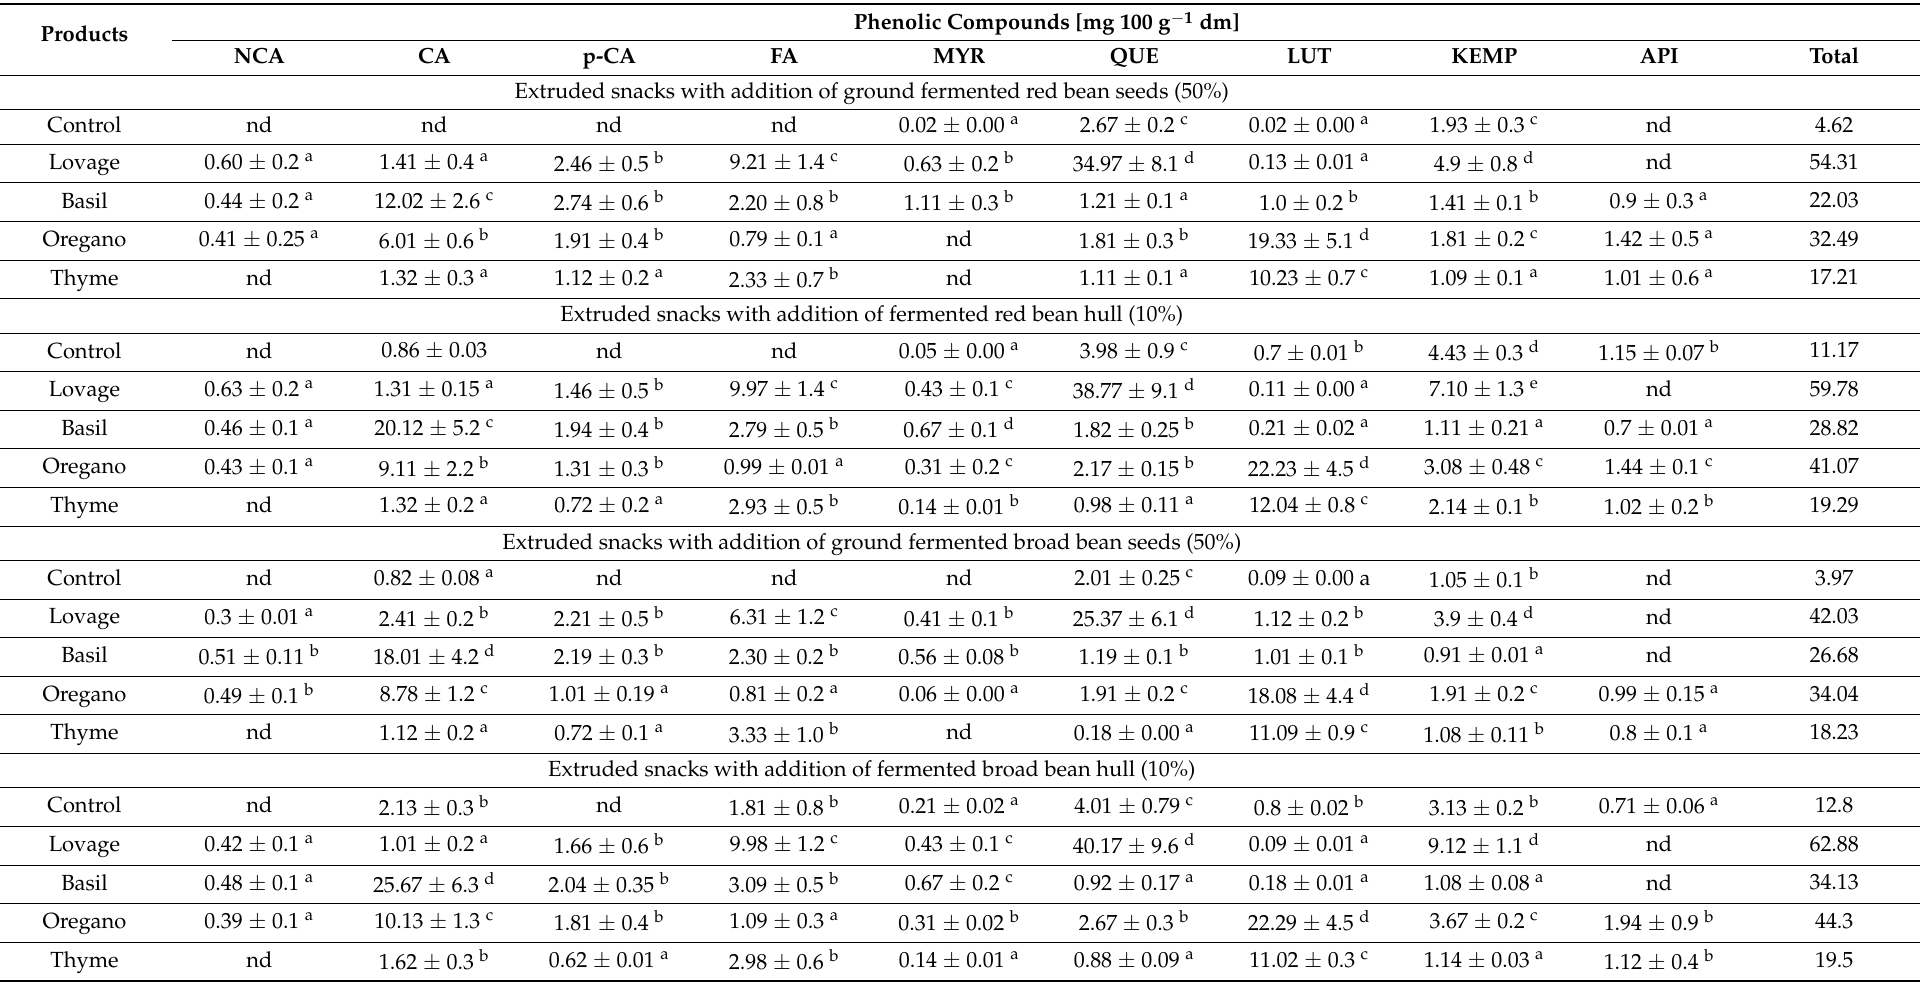
Table 2. Phenolic compounds of extruded snacks with the addition of fermented red or broad bean seeds/hulls and with herbs/species (0.5%), and the controls (without herbs/spices